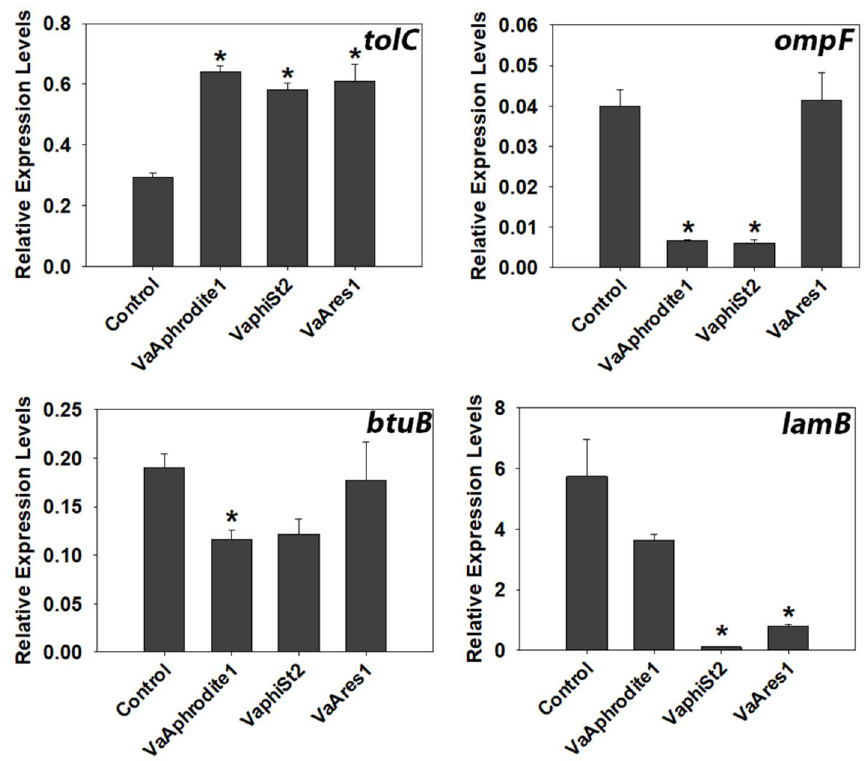
Figure 3. Relative expression levels of genes encoding for outer membrane and transmembrane proteins. Bars represent means ± SE of independent biological repeats ( n = 3). Asterisks * indicate significantly different values based on Student’s t -test. Statistical significance was postulated for p ≤ 0.05.